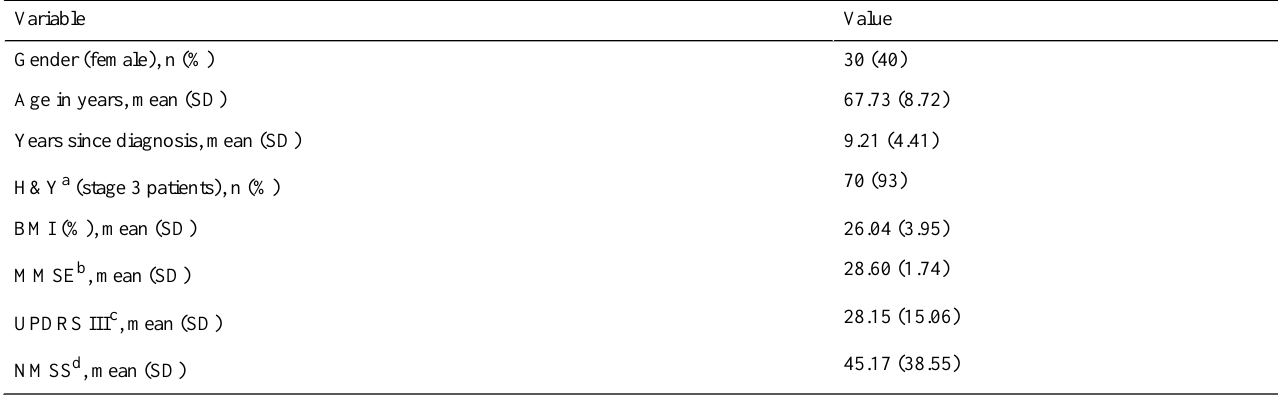
Table 1. PD_manager group characteristics